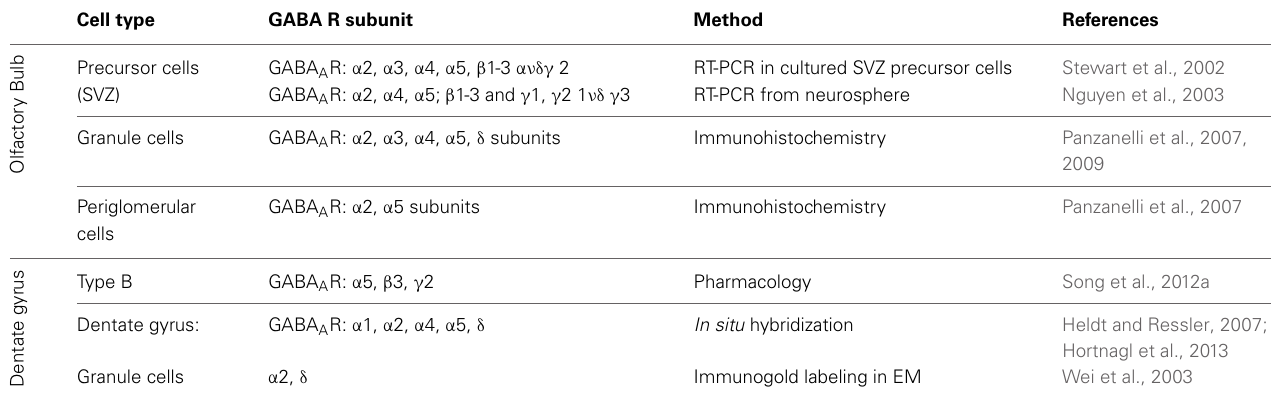
Table 1 | Distribution of various GABA A R subunits in different cell types in olfactory bulb, subventricular zone (SVZ) and dentate gyrus of the